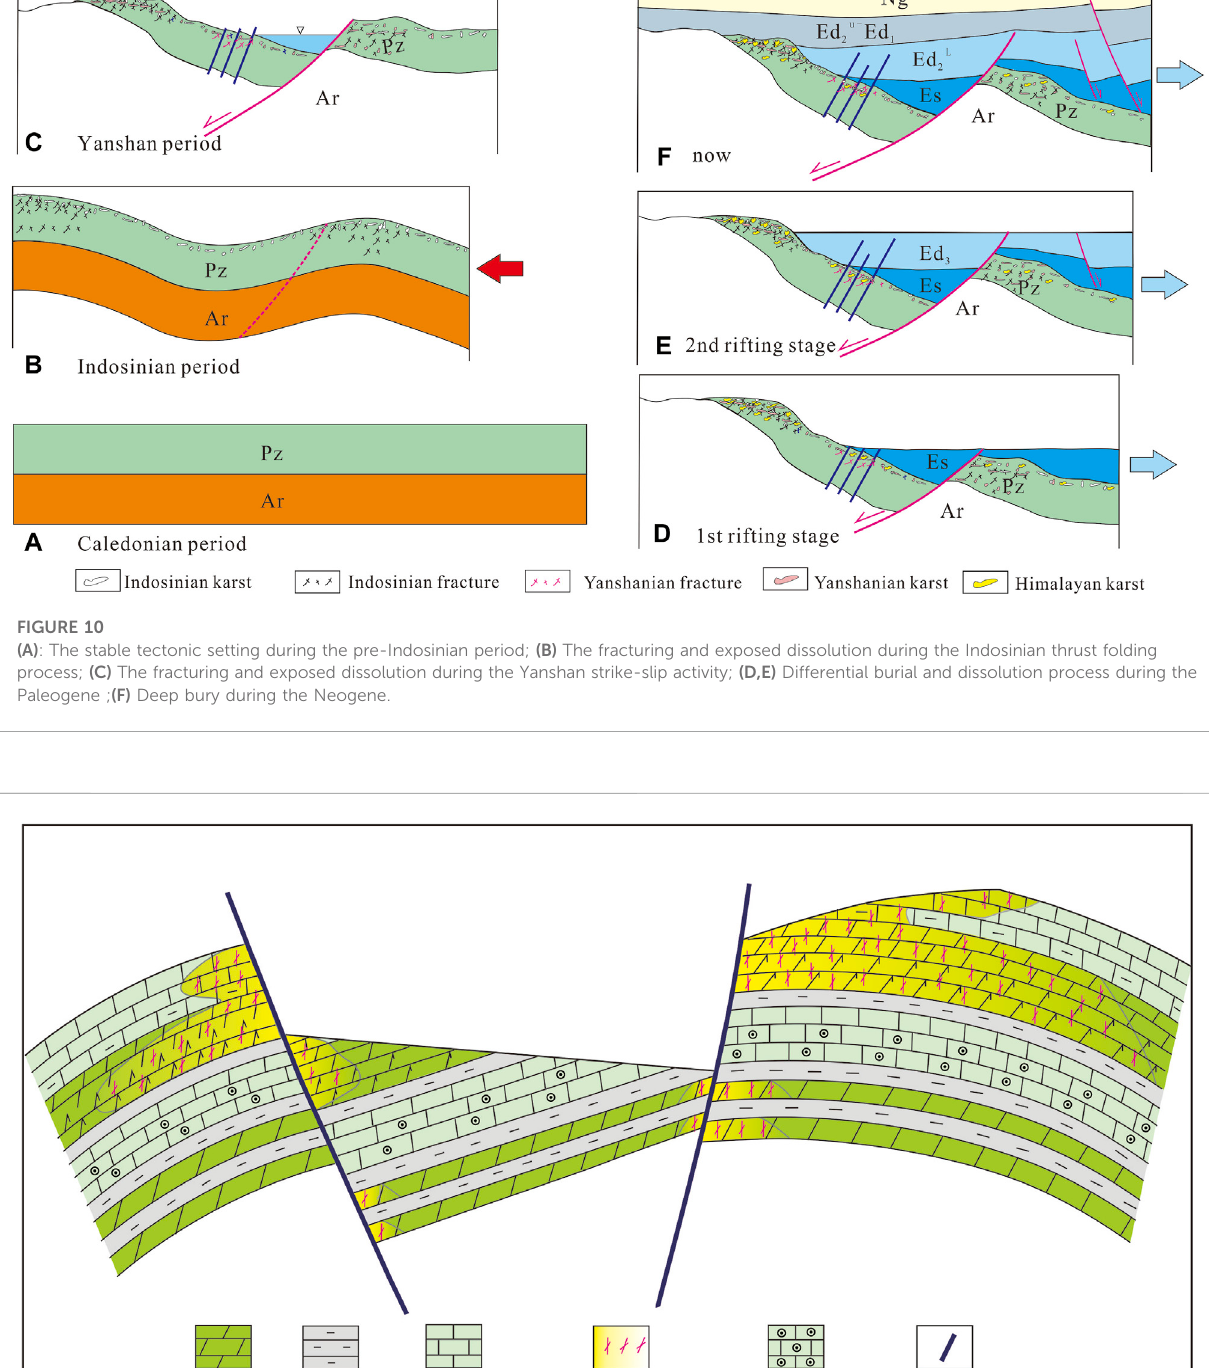
further improved the physical properties of the reservoirs and guaranteed the development of effective high-quality reservoirs (Figure 11).